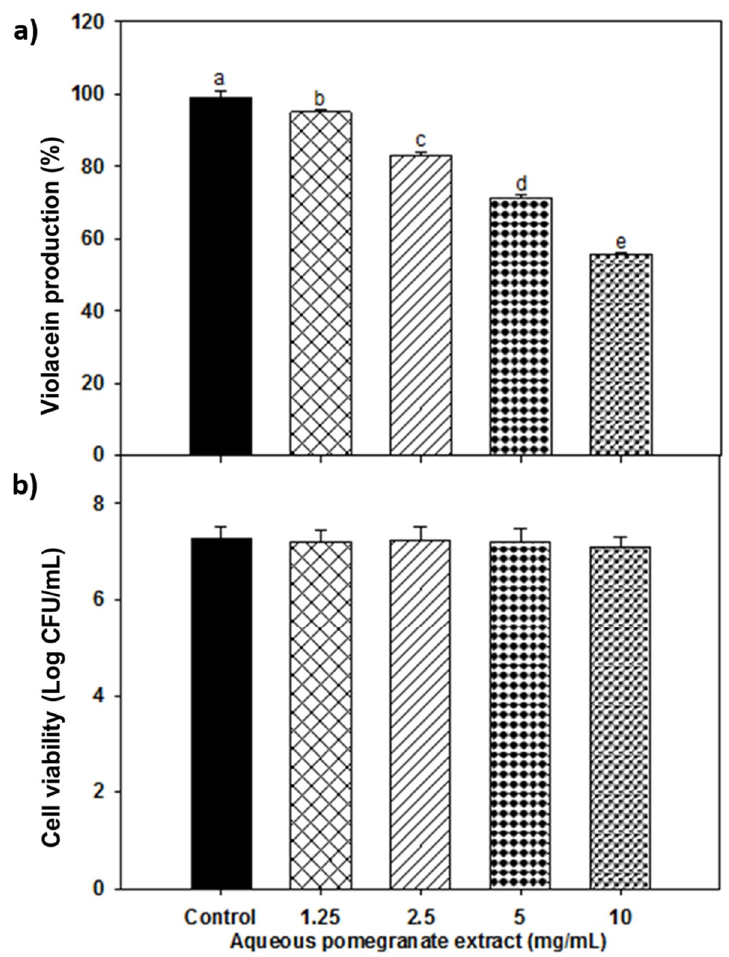
Figure 2. ( a ) Inhibition of violacein production of Chromobacterium violaceum exposed to aqueous pomegranate extract at different doses. Different letters among bars indicated significant differences ( p ≤ 0.05). ( b ) Cell viability of C. violaceum after 24 h incubation with aqueous pomegranate treat- ments.